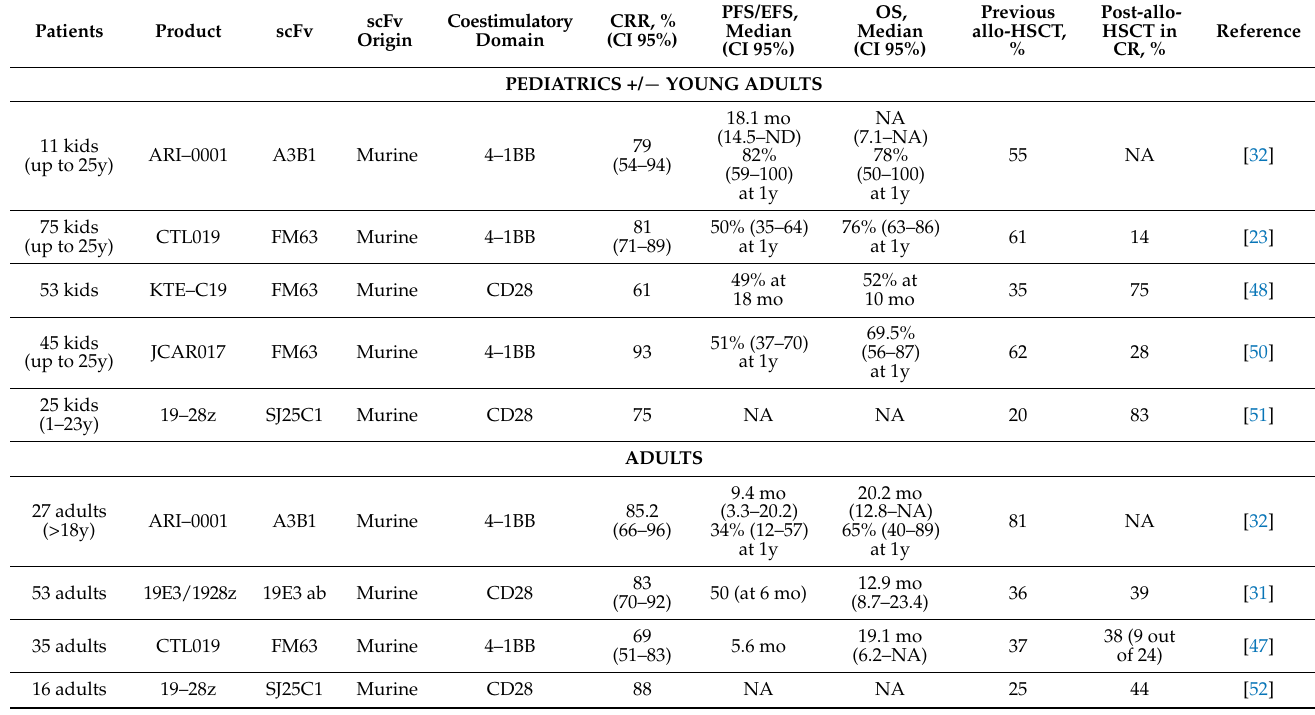
Table 1. Summary of results by relevant clinical trials with CAR-T